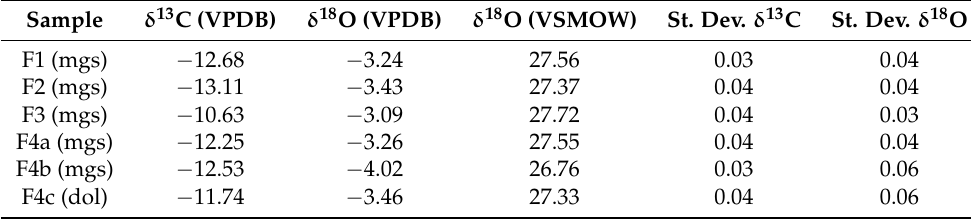
Table 2. δ 13 C and δ 18 O and standard deviation of carbonates from all